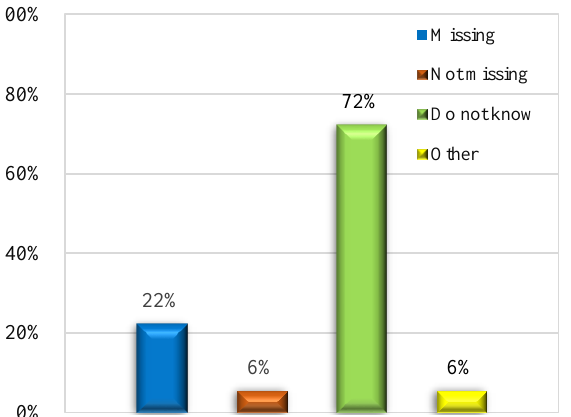
Figure 13. Comparison of combined results regarding lack of wood construction knowledge of newly